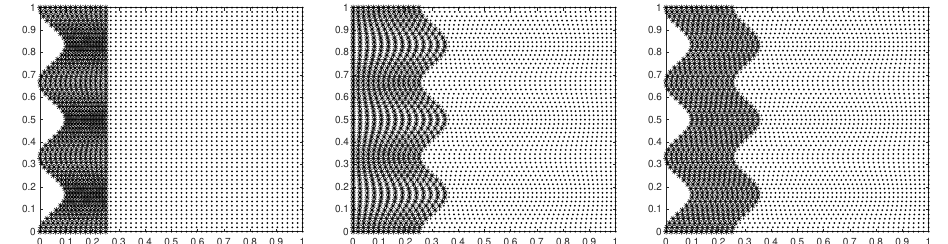
Fig. 11. Entropy generation maps due to heat transfer: (a) Ra 10 3 , (b) Ra 10 4 and (c) Ra 10 5 . ¼ ¼ ¼